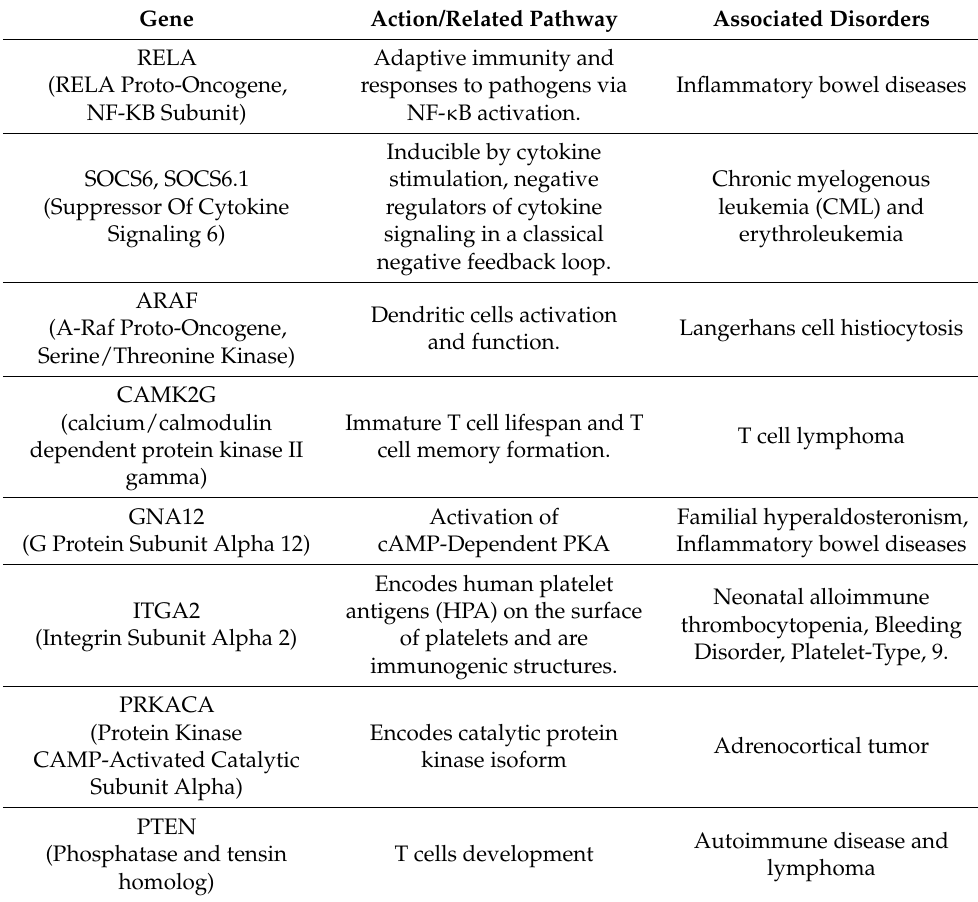
Table 2. The list of genes with a high degree of compatibility between BA and poly I:C treated liver organoids and their related actions. Gene Action/Related Pathway Associated